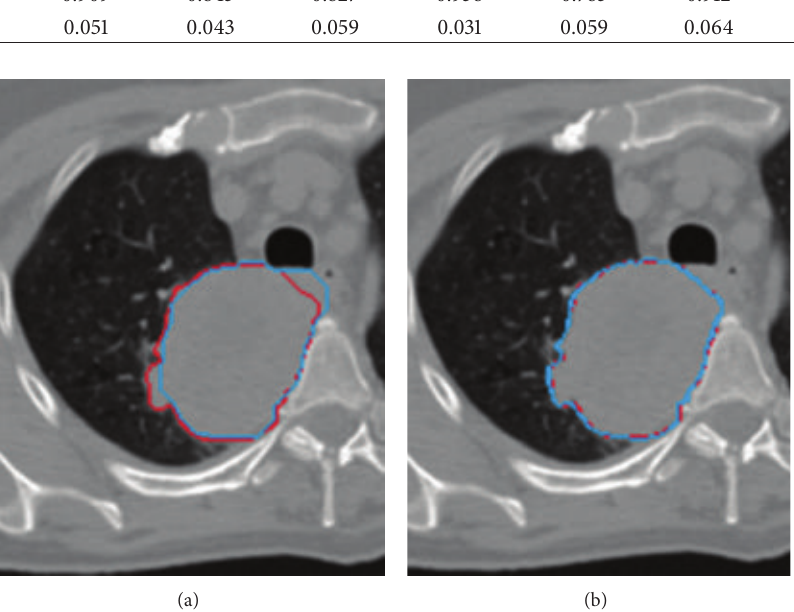
Figure 3: Comparison of automated contouring methods with ground-truth in case 1. (a) Manual contour (red) compared with MPSL (turquoise) based segmentation of GTV. (b) Manual contour (red) compared with DIR based contour